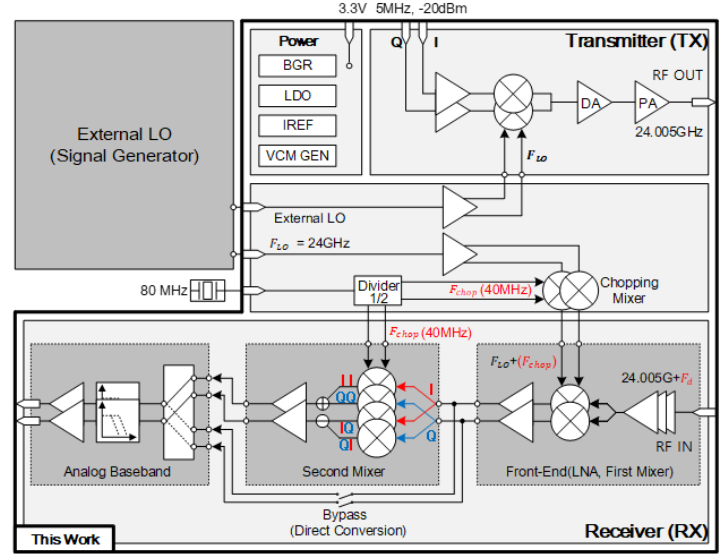
Figure 4. Block diagram of the proposed multi-mode radar transceiver.